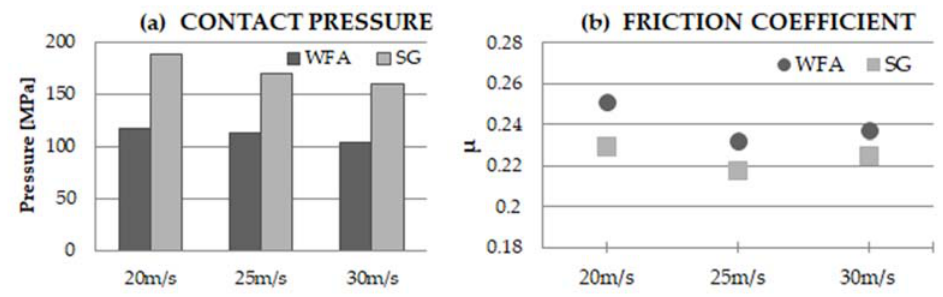
Figure 8. ( a ) Real contact pressure variation and ( b ) friction coefficient variation with sliding speed for WFA and SG alumina.